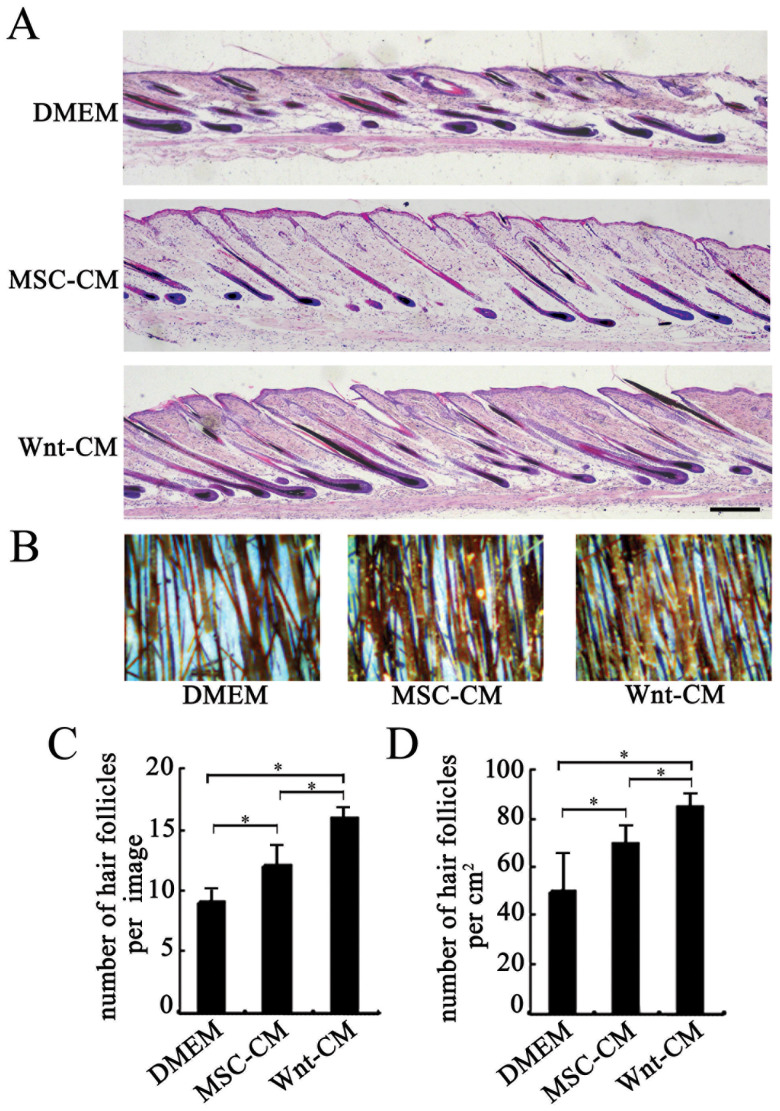
Wnt-CM increases the number of hairs in mice.(A) HE-stained dorsal skin sections at 14 days after depilation and (C) quantitative analysis of the number of hair follicles. (B) Typical photos of dorsal skin of C57BL/6 mice at 21 days after depilation and (D) quantitative analysis of the number of hair shafts. The data represent the means ± SEM, n = 3. *P < 0.05. Scale bar (A–C) = 100 μm.